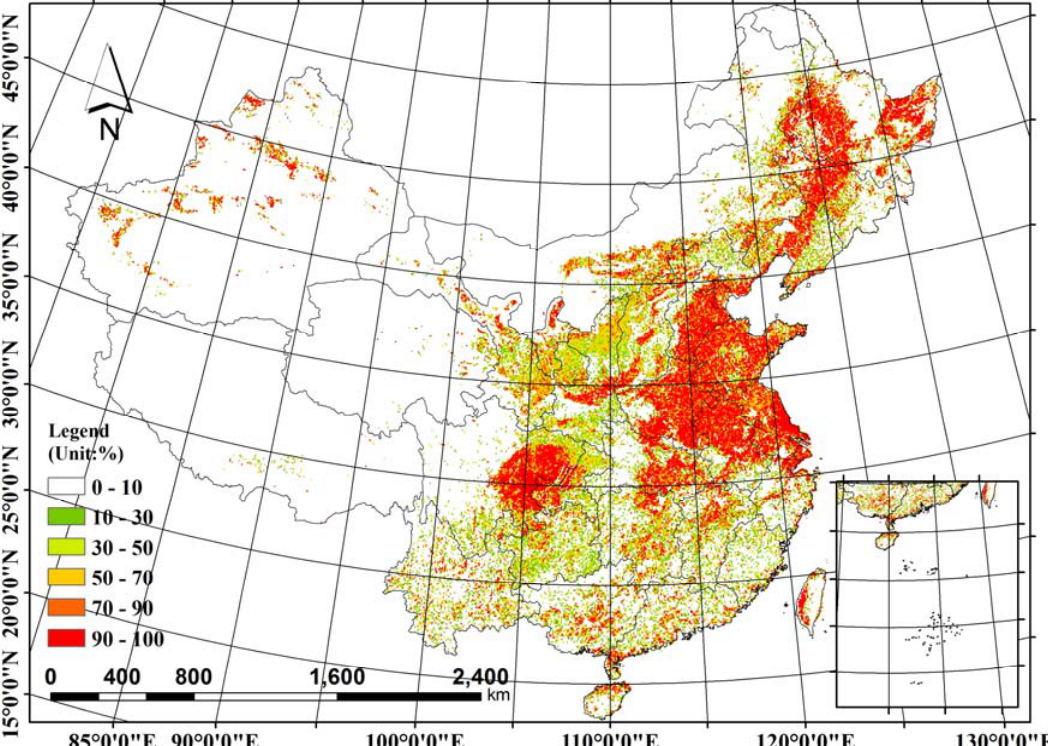
Figure 1. Map of cropland density in China at a resolution of 8